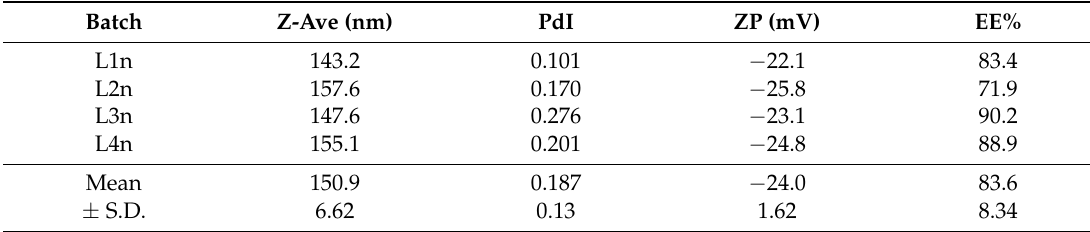
Table 3. Experimental data for the Nile red-loaded